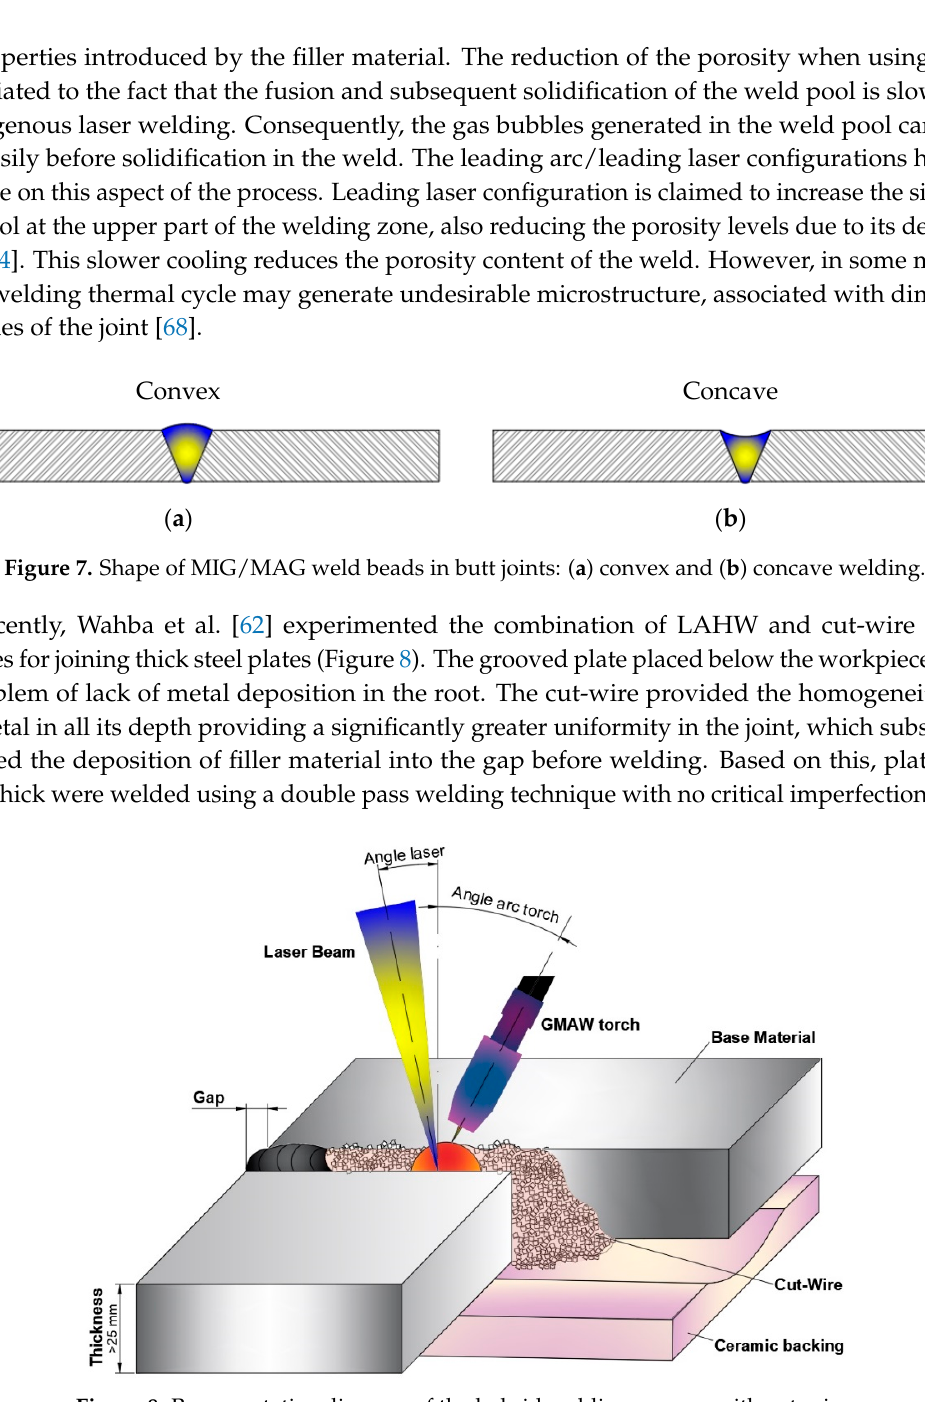
Figure 8. Representative diagram of the hybrid welding process with cut-wire.